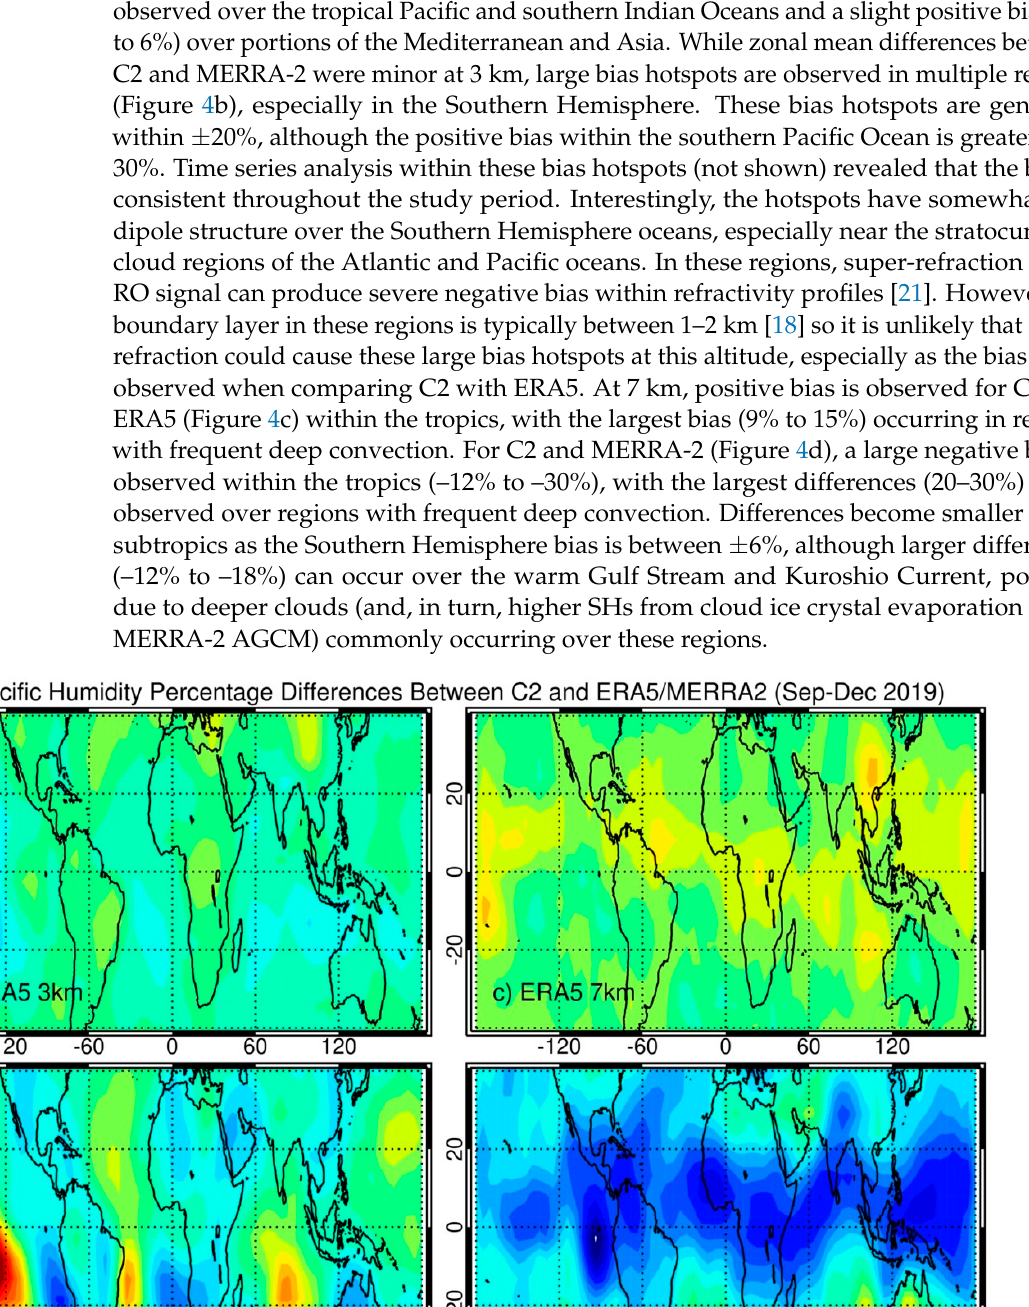
values at the selected altitudes from all collocated C2 and reanalysis profile pairs within 5 ° x 5 ° grids. Correlations between C2 and each reanalysis are generally strong, with the best agreement in the subtropics and slightly weaker correlations in the tropics. Correla- tion coefficients between C2 and ERA5 pairs are often greater than 0.9 at 3 km (Figure 5a). However, slightly poorer correlations are observed throughout the deep tropics (10 ° N– 10 ° S) along with some lower correlation hotspots in regions that see frequent deep con- vection, such as central Africa and northern South America (which will be shown in greater detail later in the study). C2 and MERRA-2 pairs at 3 km (Figure 5b) show slightly poorer correlations throughout the entire study region, and smaller coefficients (0.4–0.7) are more consistently observed throughout the entirety of the deep tropics. For C2 and ERA5 at 7 km (Figure 5c), agreement is even better compared to 3 km, with gridded coef- ficients in the deep tropics now above 0.8. However, correlations are again weaker for C2 and MERRA-2 (Figure 5d), with some gridded coefficients in the equatorial Pacific smaller by 0.3–0.5. Interestingly, correlations over many of the subtropical dry regions, such as northern Africa and Australia, are poorer at 7 km relative to 3 km, but the reason for this is unclear.